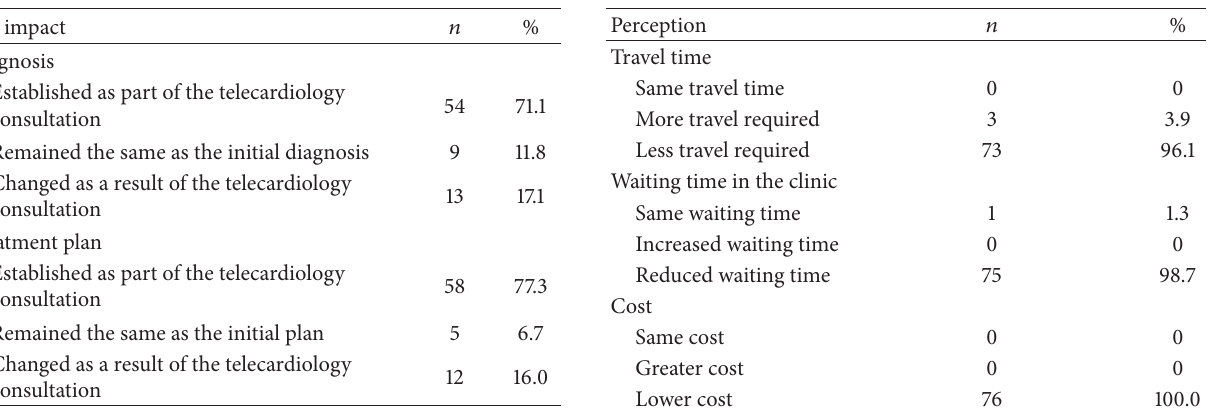
Table 2: The impact of telecardiology consultations on changes in diagnosis and treatment plan according to the perception of the referring providers.